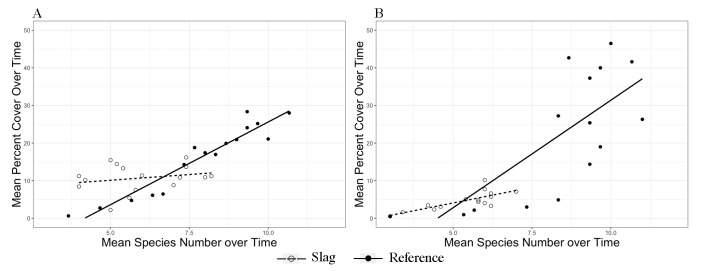
Linear regression of mean percent cover versus mean species number in germination plots.(A) BM. (B) VV. Slopes of regression lines are different for plots on Slag (dashed line) and Reference (solid line) sites. See Table E in S1 File for complete statistics.